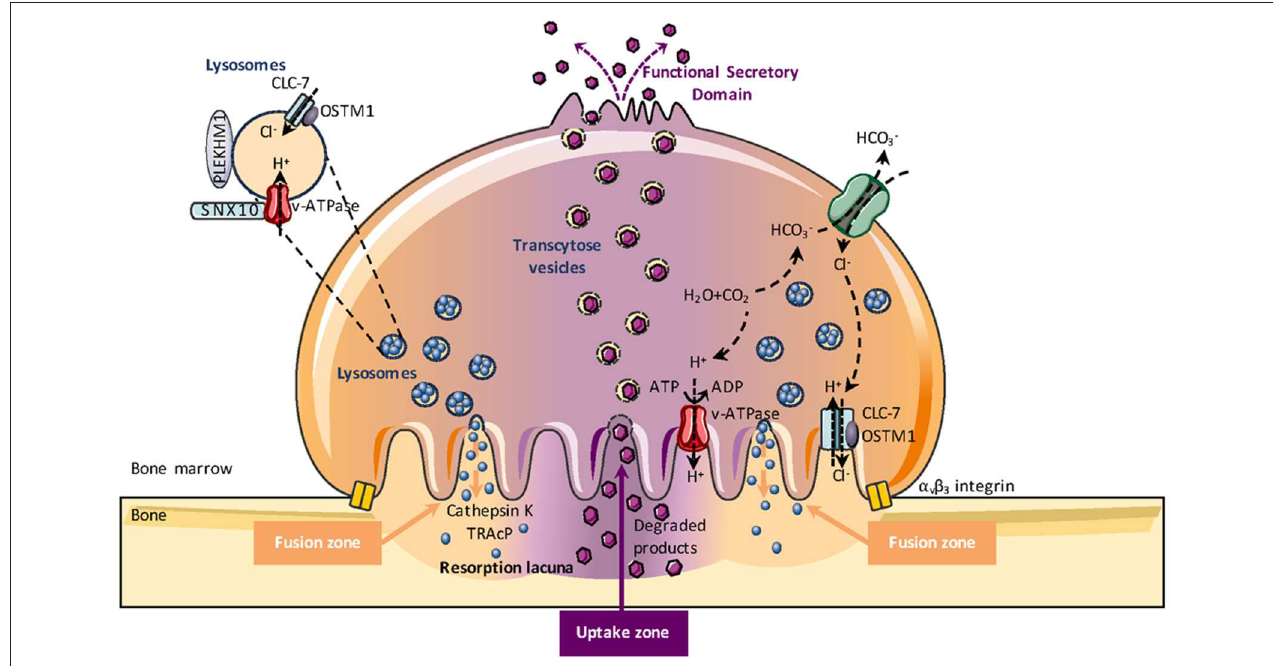
FIGURE 3 | Osteoclast-mediated bone resorption. Bone degradation requires the extracellular secretion of lysosomal enzymes, such as TRAcP (Tartrate-resistant acid phosphatase) and cathepsin K into the resorption lacuna. This exocytosis of lysosomes occurs in the peripheral region of the ruffled border (fusion zone) and is guided by PLEKHM1, OSTM1, and SNX10. Proton pumps (v-ATPase) and the CLC7-antiporter are relocated at the ruffled border plasma membrane of bone-resorbing OCLs and mediate extracellular acidification for bone demineralization during bone resorption. The v-ATPase transports protons obtained by carbohydrase-dependent hydration from CO 2 to H 2 CO 3 into the resorption lacuna while HCO + 3 is excreted via the Cl − /HCO 3 exchanger. Molecular degradation products generated during bone resorption are released through the central region of the ruffled border (uptake zone). Through transcytosis trading, vacuoles are able to cross the OCL cytoplasm and exit the OCL from the so-called “functional secretory zone” at the basolateral plasma membrane into the vascular